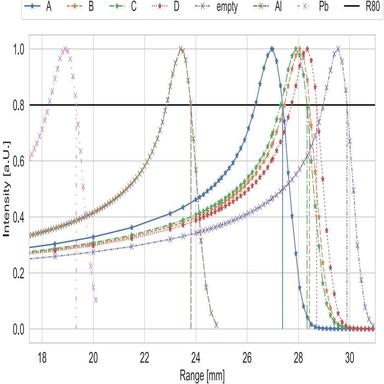
Relative range measurements of four textiles in comparison to Pb, Al, and only water (i.e. empty). The proton range is defined at the 80% fall-off behind the Bragg peak. Details on the space suit materials are listed in.